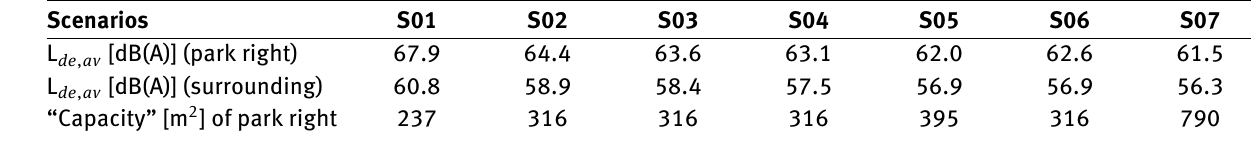
Table 7: L de , av average values in the right hand side of the park and the park surrounding for each of the scenarios. Scenarios